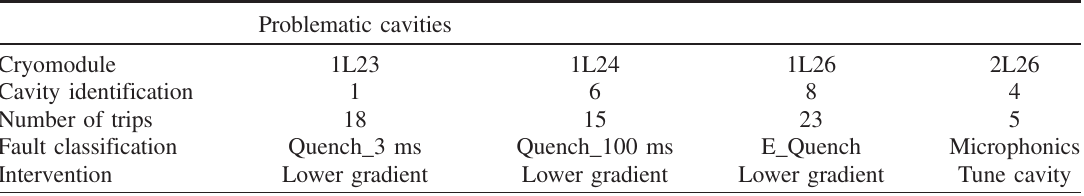
CHRIS TENNANT et TABLE IV. Problematic cavities as identified by the machine learning models during a two-week test run in March 2020. The cavity identities, number of times the cavity tripped, fault types, and suggested interventions are given. Problematic cavities